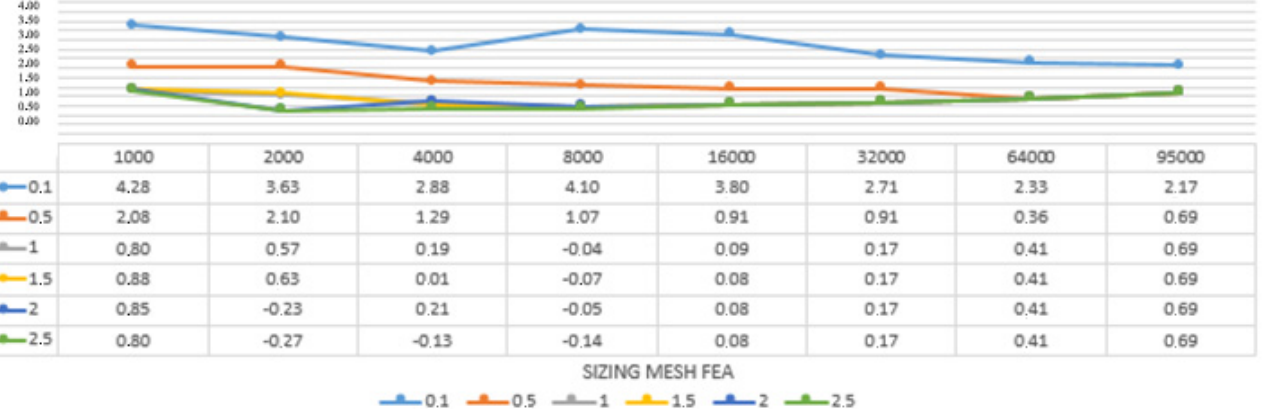
Table 9. The comparison between the dimension of the element of the superficial meshes and the volumetric element in FEA for the triangular simplified models. The column represents the dimension of the superficial mesh element, and the rows represent the dimension of the volumetric elements in the FEA